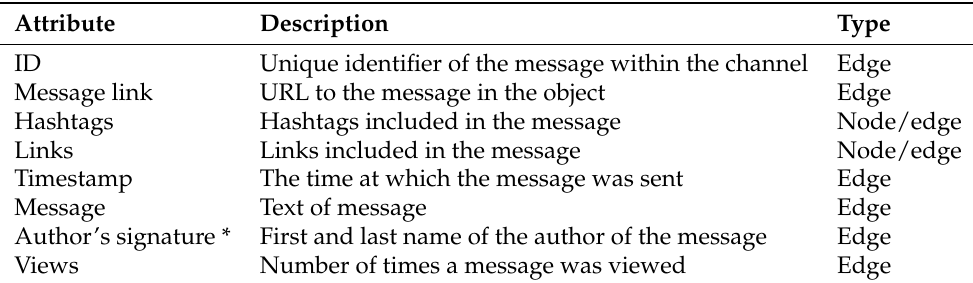
Table 3. Telegram’s attributes for building the Telegram graph and features. The field marked with an asterisk (*) is